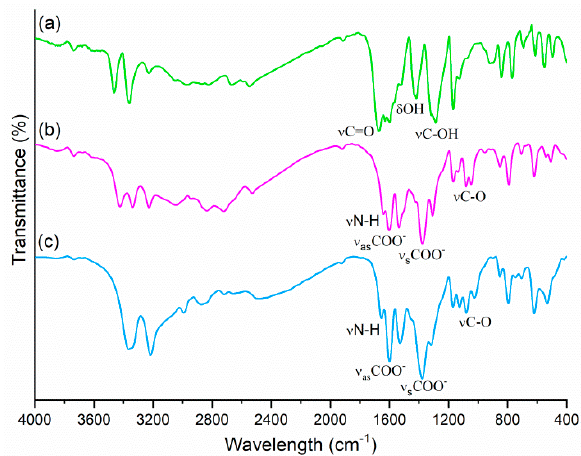
Figure 4. FTIR spectra of p ABAH ( a ), HEEA- p ABA ( b ) and HDEEA- p ABA ( c ).